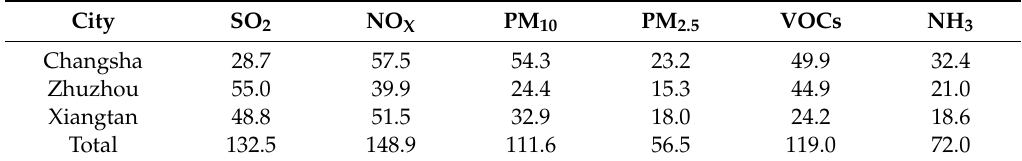
Table 1. The anthropogenic emission inventories of the Changzhutan urban agglomeration in 2015 (kt). City SO